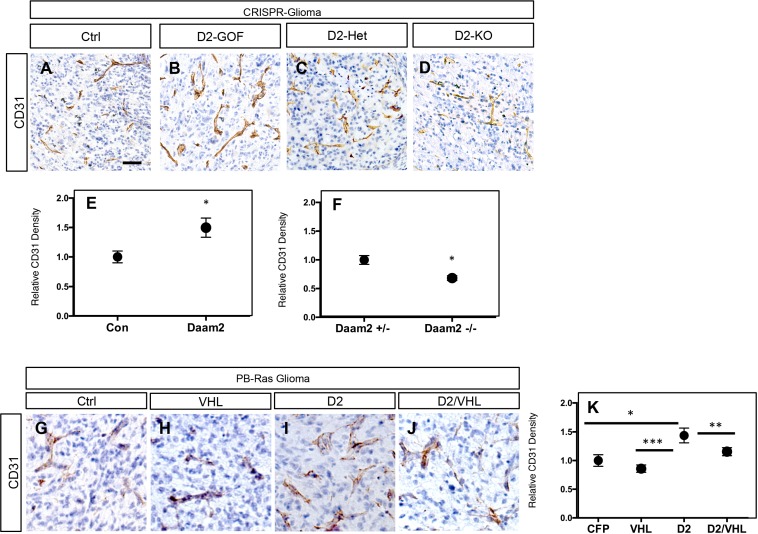
Manipulation of Daam2 expression influences angiogenesis.Representative immunohistochemistry staining of the vascular marker, CD31, in our glioma model, across a series of experimental manipulations. (A–B) CRISPR-IUE glioma in the context of Daam2 GOF and associated control, (C–D) CRISPR-IUE glioma generated in Daam2 ± and Daam2-/- mice; quantification in E-F. In E, *p=0.033. In F, p=0.0026. (G–J) PB-Ras glioma in the context of VHL-GOF, Daam2-GOF, Daam2 + VHL, and control. This analysis was performed on six different tumors for each condition, four slides per tumor. Quantification is in K: *p=0.034, **p=0.044, and ***p=0.023. In E, F, and K error bars are ± SEM.